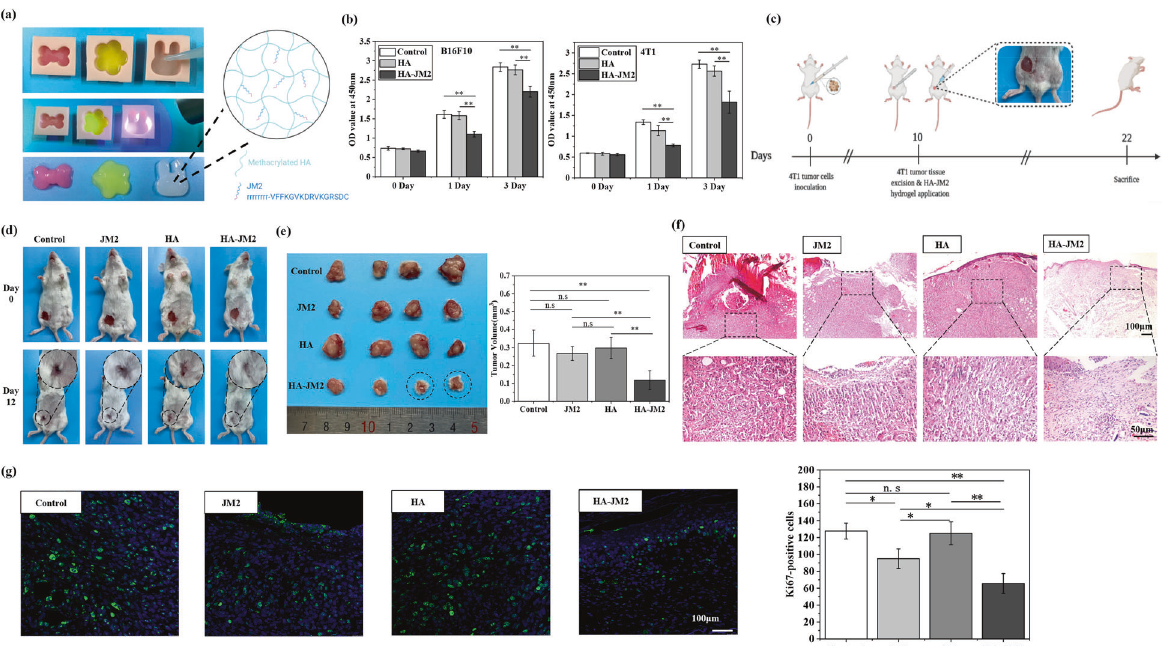
Fig. 7 HA-JM2 injectable hydrogel inhibited postsurgical tumor recurrence. a Representative pictures of HA-JM2 injectable hydrogel. b Cell proliferation evaluation of B16F10 and 4T1 cells cultured with different hydrogels. c Schematic illustration of the in vivo tumor recurrence inhibition experimental protocol. d Representative gross observation images of post-surgical observation of mice in different groups at day 0 and 12. e Representative images and statistical analysis of recurrent tumors in different groups at day 12. f H&E staining of recurrent tumors obtained from different groups at day 12. g Ki67 immuno fl uorescence staining (green) and DAPI staining (blue) of recurrent tumors obtained from different groups at day 12. Statistical image displayed the number of Ki67-positive cells. * p < 0.05 and ** p < 0.01 when the data was compared with the Control